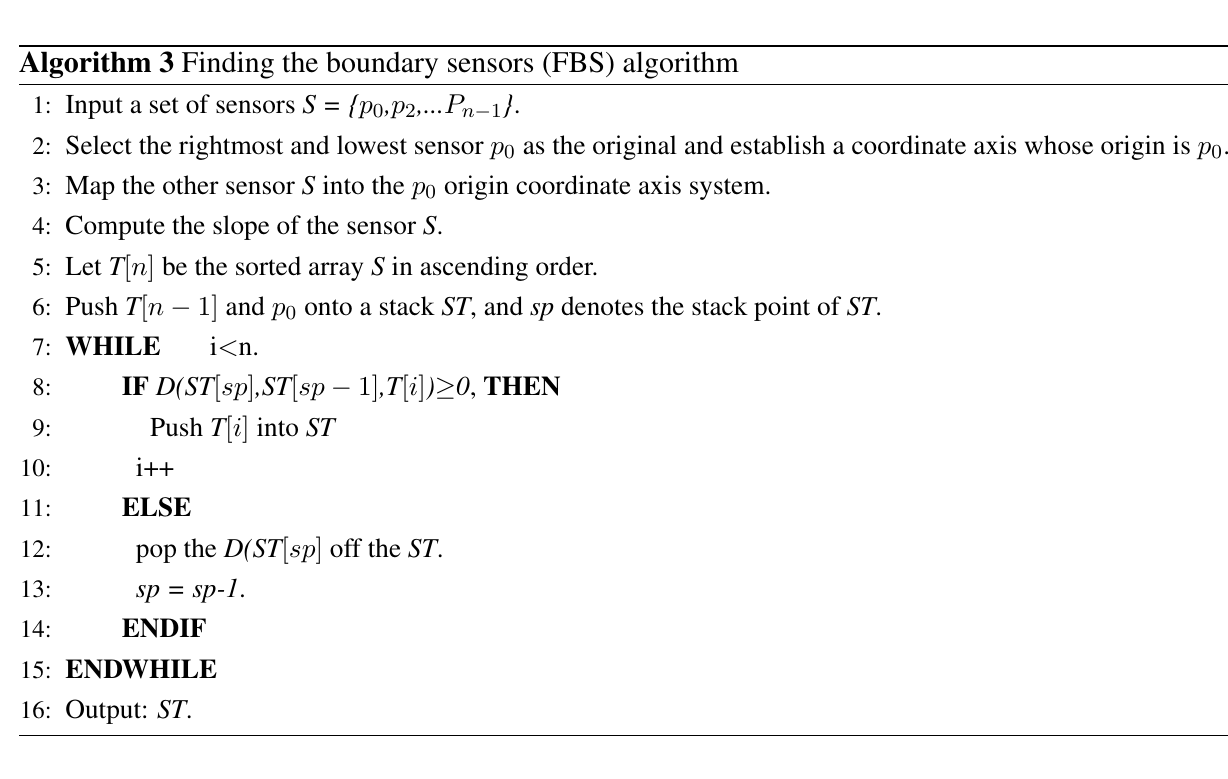
Fig 3. The minimum convex polygon